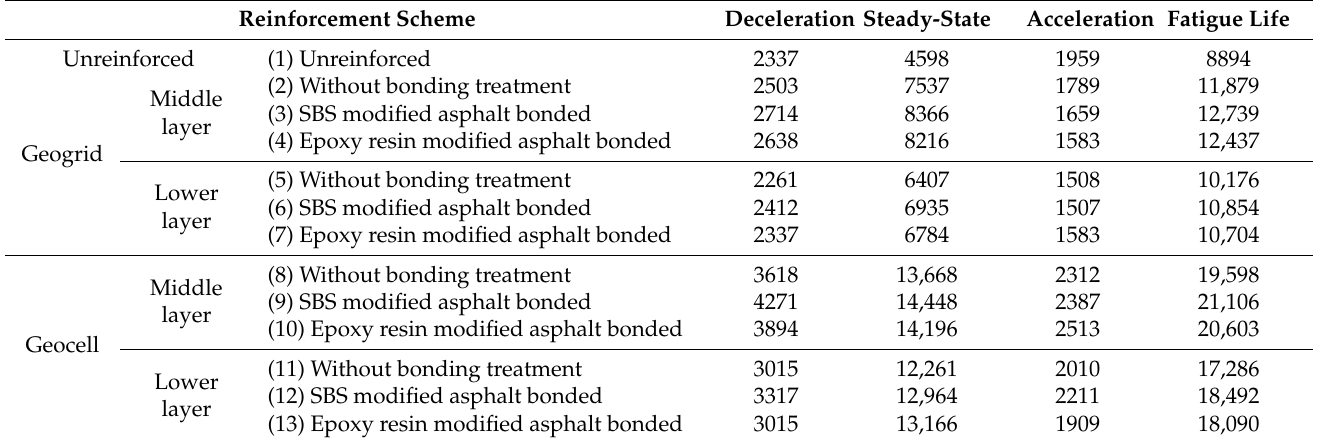
Table 8. The number of loading cycle in each fatigue stage and fatigue life. Reinforcement Scheme